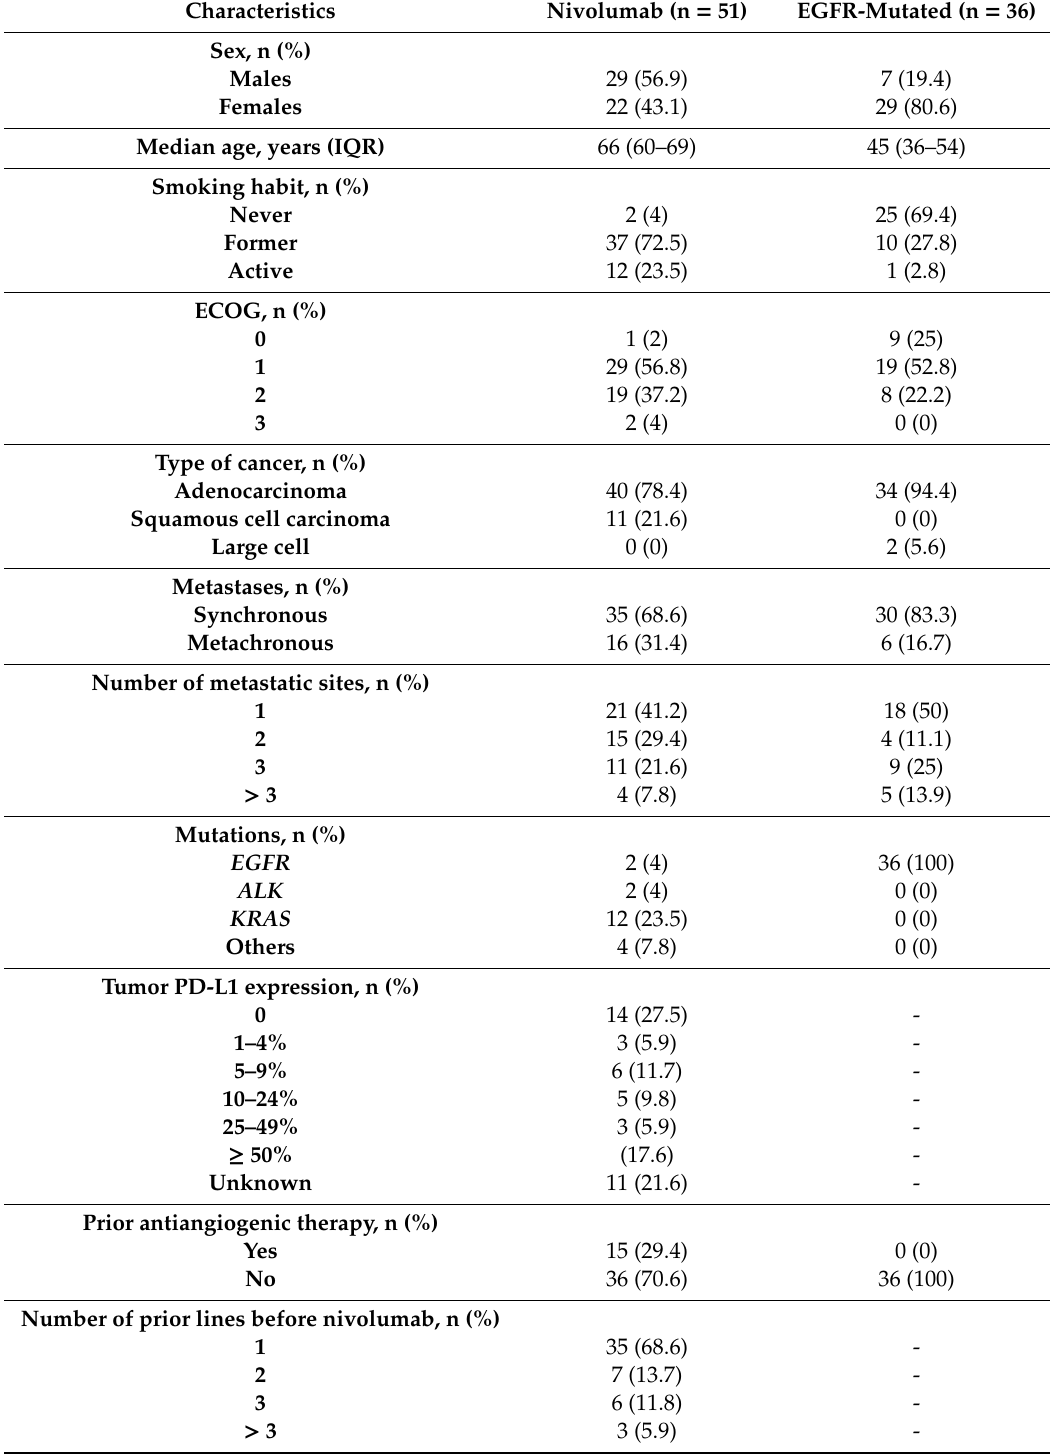
Table 1. Patients’